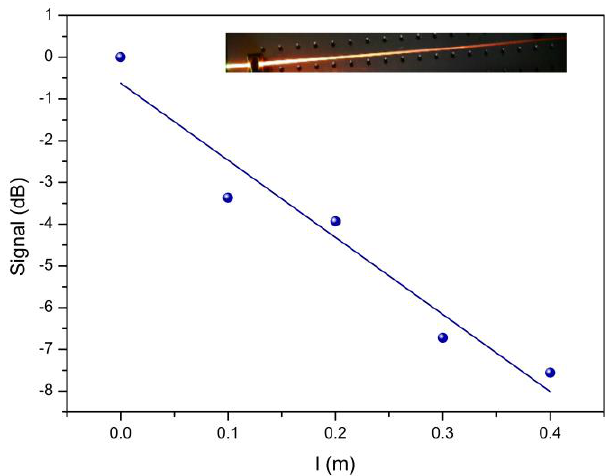
Fibers 2017 , 5 , 15 6 of 9 fluorescence λ max of Ox170 (650 nm). The monotonic decreasing tendency of FWHM is observed for distances longer than 0.08 m (λ max > 650 nm) and is resulted by reabsorption of fluorescence radiation in dye-doped polymeric fiber. The nearly linear dependence can be noticed for fiber length longer than 0.3 m since the luminescence wavelength is situated on the right tail of Ox170 fluorescence spectrum. The decreasing of spectrum width is expected then as the absorption plays a significant role in the final luminescence spectrum shape. ( a ) ( b ) Figure 5. ( a ) The λ max shift vs. fiber length, ( b ) The FWHM of luminescence spectrum vs. fiber length. The absorption of Ox170 molecules causes strong signal attenuation. The significant spectrum shape modification (λ max and FWHM) can be observed then. Measured attenuation for fluorescence signal (λ max ) slope equals 18.5 dB/m and is presented in Figure 6. High attenuation of fluorescence signal limits the useful fiber length. In fact, the organic dyes doped polymeric luminescent fibers length is limited to tenths of centimeters. The measured fluorescent properties of Ox170 doped PMMA fiber strongly correspond to spectroscopic properties of the used dye. The λ max and FWHM of fluorescence spectra can be directly interpreted using absorption end emission spectra of Ox170. Moreover, the possibility of fluorescent spectrum shape modification can be used in numerous optical application and desired fluorescence spectrum can be obtained using optimized POFs. The